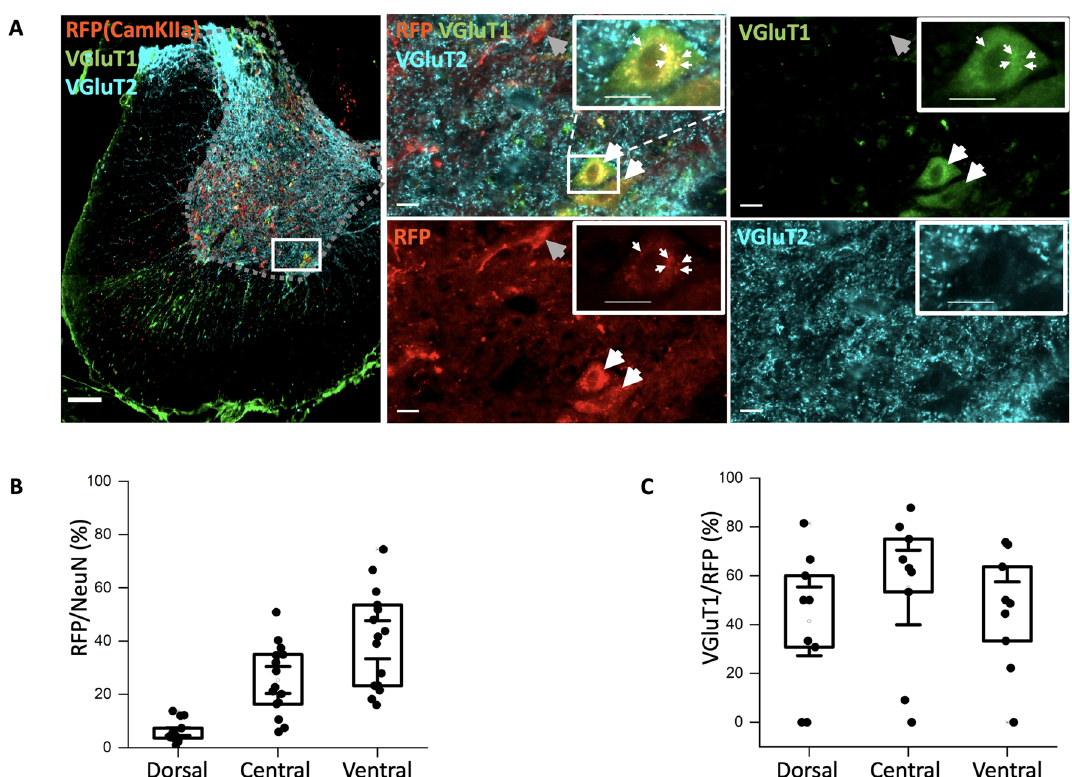
Figure 4. Infection of spinal neurons with AAV9-CamKIIa primarily in the central and ventral regions. ( A ) Overview of infection (red, mScarlet designated here as RFP) in the half spinal section combined with the immunostaining of VGluT1 (green) and 2 (cyan) and zoomed in images of a highlighted region in half section and the immunostaining of VGluT1 and 2 (green and cyan), indicates some overlap with VGluT1, whereas the VGluT2 primarily stains the synaptic terminals. ( B ) Counting neurons (NeuN) that co-expressed with the cells expressing RFP (N = 6 animals, n = 3 sections/animal). ( C ) Box plot of the co-expressed cell count with VGluT1 positive neurons (N = 3 animals, n = 3 sections/animal). Scale bar 200 µ m in image A (left) and 20 µ m in the